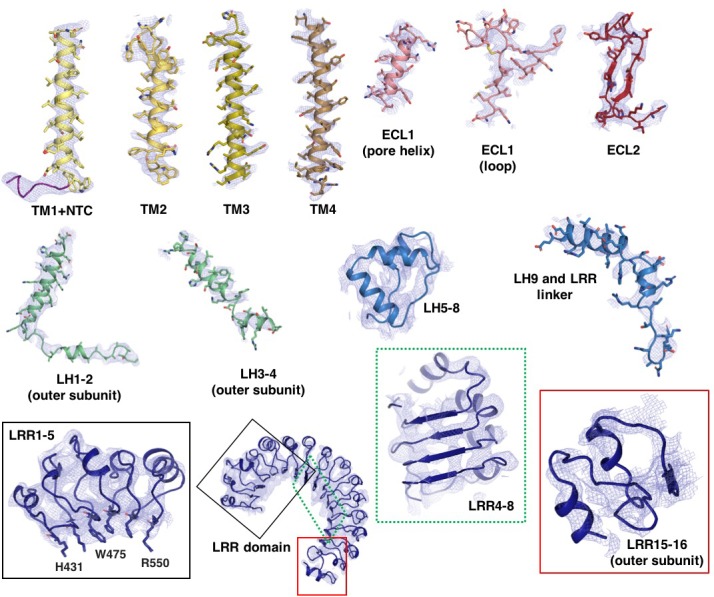
Model-to-map fit of electron density.Selected regions of the model are shown with superimposed electron density. Density is derived from the final C3 symmetry-imposed map sharpened with a b-factor of −110 Å2. The cytosolic loop helices (LH1-4) and LRR 15–16 are from the outer subunit.